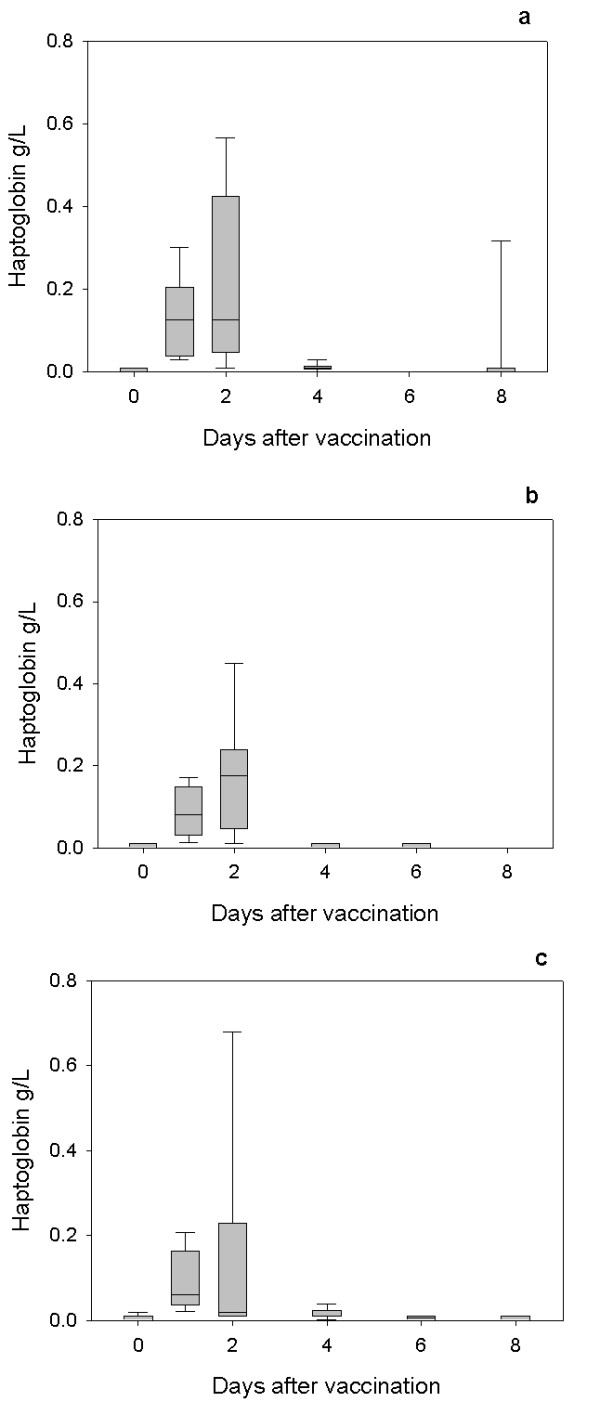
Hp response to the second vaccination with Heptavac. The concentrations of haptoglobin in lambs (n = 10) following the second vaccination with Heptavac. The maternal diets of the lambs were High/High (a), High/Low (b) and Low/High (c). The plots show the median as the line in the box, the 25th and 75th percentile are represented by the box with the whiskers representing the 10th and 90th percentiles.